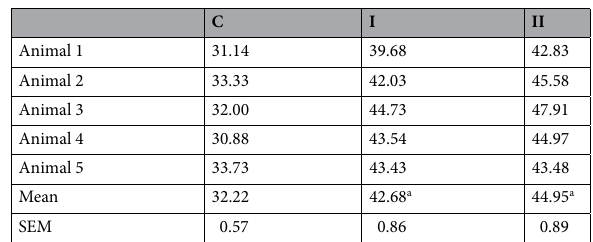
Table 1. The percentage of neurons immunoreactive to vasoactive intestinal polypeptide (VIP) in the wall of urinary bladder trigone (in relation to all PGP 9.5—positive cells) in the control group (C), the experimental group I (I) and experimental group II (II). The results were considered statistically significant at p < 0.05 and are marked with a